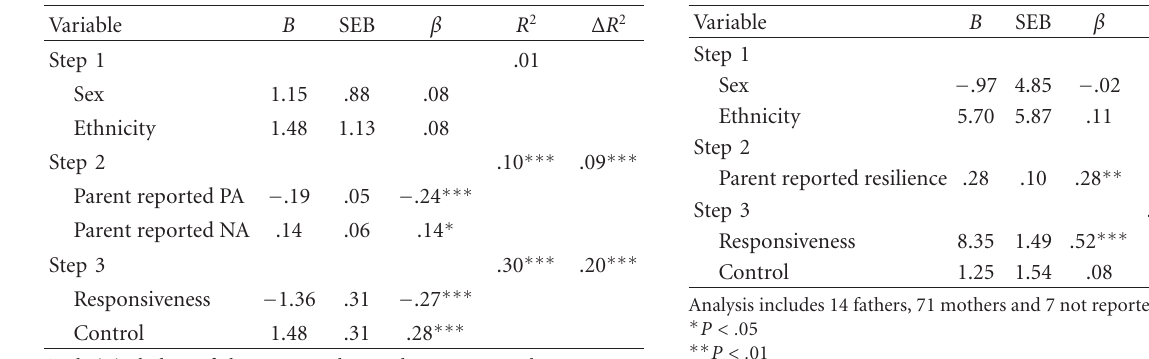
Table 2: E ff ect of parental responsiveness and psychological control in predicting child mood after controlling sex, ethnicity, and parent- reported child positive and negative a ff ect ( N = 268).